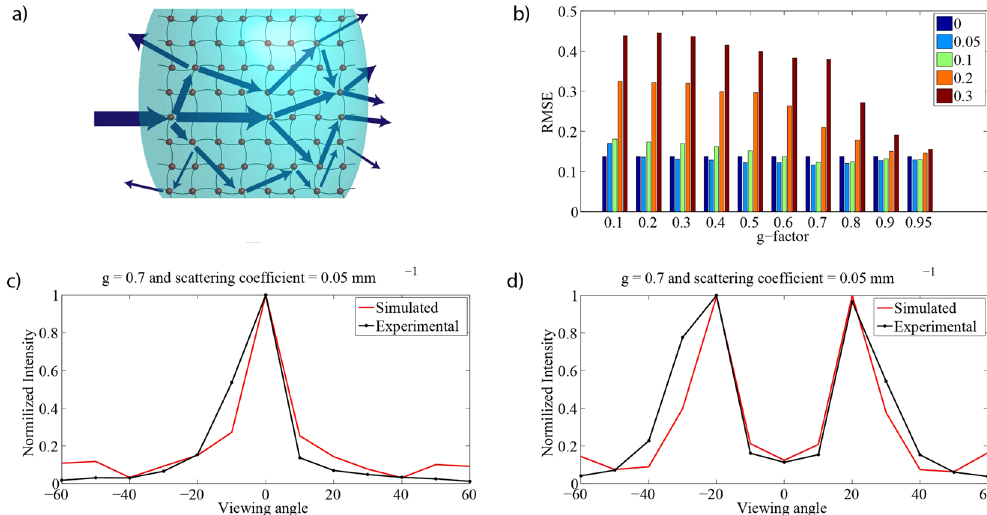
Figure 3. ( a ) Schematic representation of scattering in silk protein hydrogel. ( b ) Root mean square error between experimental and ray tracing results. Scattering coefficient was varied between 0 and 0.3 mm − 1 and g-factor was varied between 0.1 and 0.95. ( c ) Experimental measurement and simulated ray tracing of intensity distribution of spatial radiation for dome-type lens and ( d ) for crater- type lens while minimum error was obtained at a scattering coefficient of 0.05 mm − 1 and g-factor of